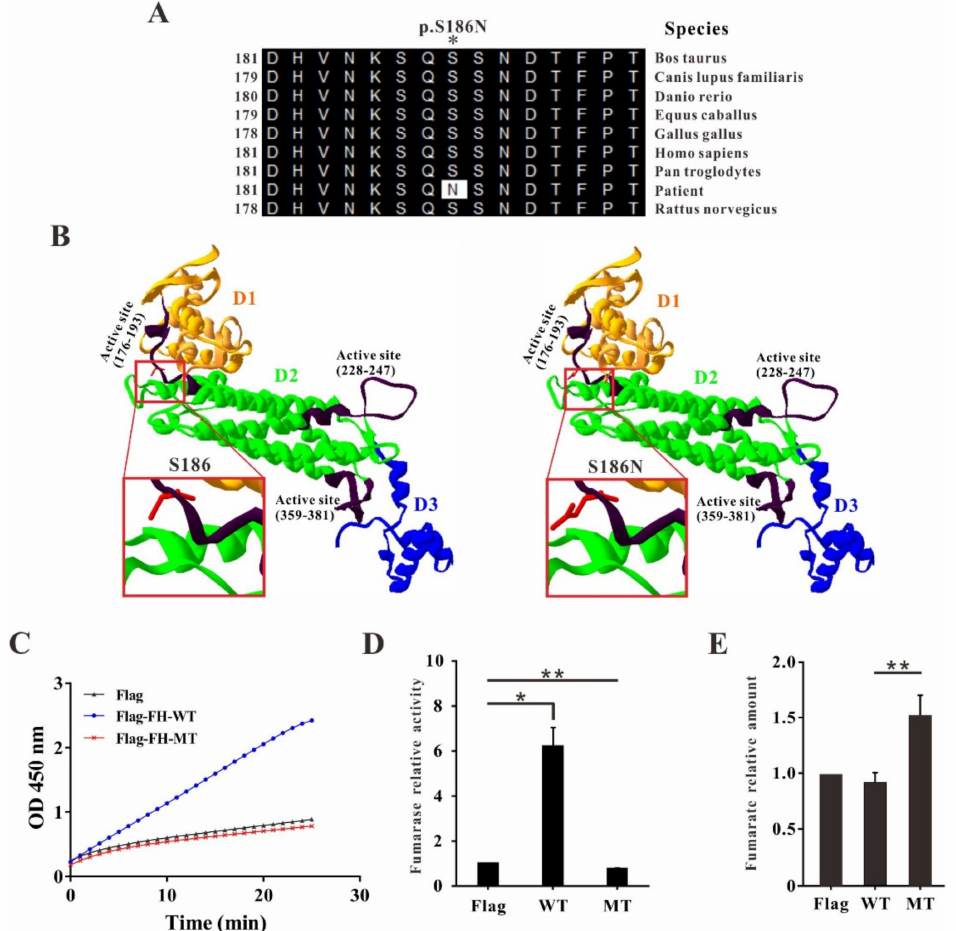
Figure 2. Analysis of FH mutation. ( A ) Evolutionary conservation of amino acid residues al- tered by c.557G>A (p.S186N) across different species. NCBI accession numbers are: Bos Taurus: NP_001069271.1; Canis lupus familiaris: XP_537215.1; Danio rerio: NP_957257.1; Equus caballus: XP_023488568.1; Gallus gallus: NP_001006382.1; Homo sapiens: NP_000134.2; Pan troglodytes: NP_001267172.1; Rattus norvegicus: NP_058701.2. ( B ) The mutant protein was structured by Swiss- Model online software compared to the wildtype. Three domains of FH monomer are shown with different colors, D1-yellow, D2-green and D3-blue. Three active sites from each monomer are pre- sented in black. Amino acid S186 and S186N are shown as red sticks. ( C ) The absorbances were measured at 450 nm in kinetic mode with Flag-FH wildtype or mutant stable overexpression HEK293T cells. ( D ) Relative fumarase activity was calculated in corresponding cells. ( E ) Cellular fumarates level was significantly increased in FH mutant overexpression cells (* p < 0.05, ** p < 0.01). All data are presented as the mean ± SD from at least three separate